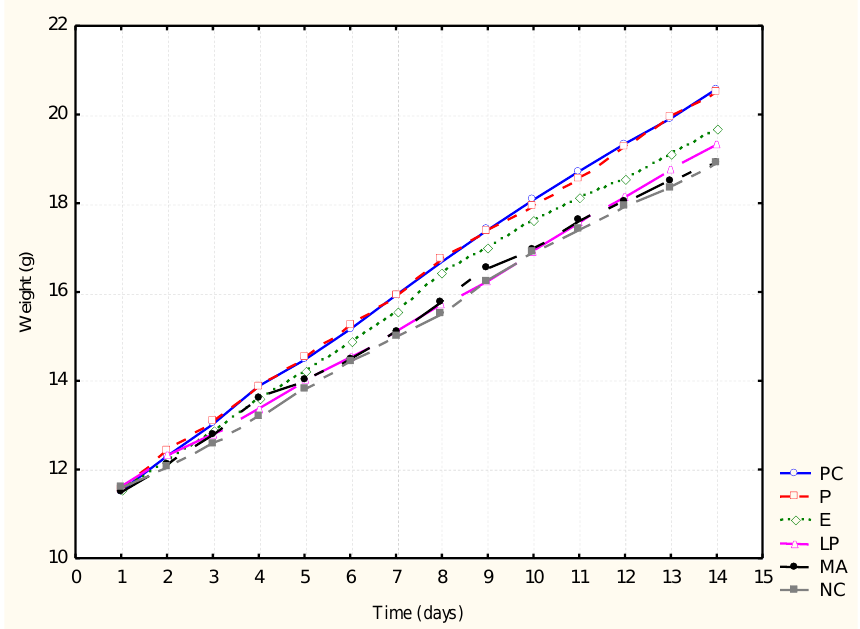
Figure 1. Dynamics of the live body weight of the mice fed with the different experimental diets (six animals per group): group P (mineral phosphorus); group E (encapsulated phytase of Obesumbacterium proteus (OPP), derived from the recombinant Yarrowia lipolytica PO1f (pUV3-Op) strain); group LP (commercial Ladozyme Proxi soluble phytase) and group MA (mock additive derived from the non-recombinant Y. lipolytica PO1f strain). Each growth curve is shown in the same graph with the balanced diet deficient in phosphorus (NC) and the balanced diet with adequate phosphorus (PC).